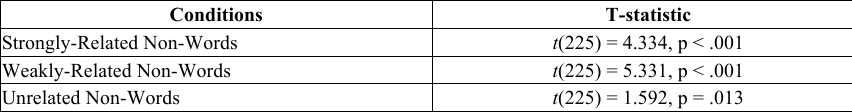
Table 3. Between-Subject Analysis for Non-Word